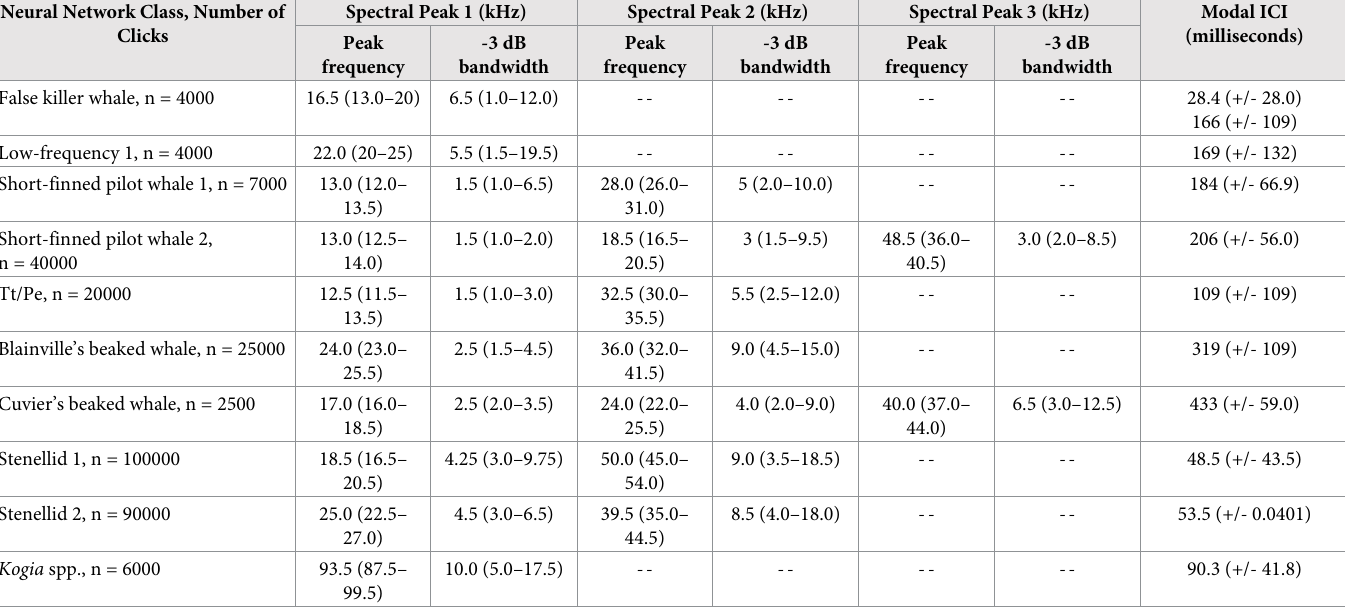
Table 1. Quantitative click type